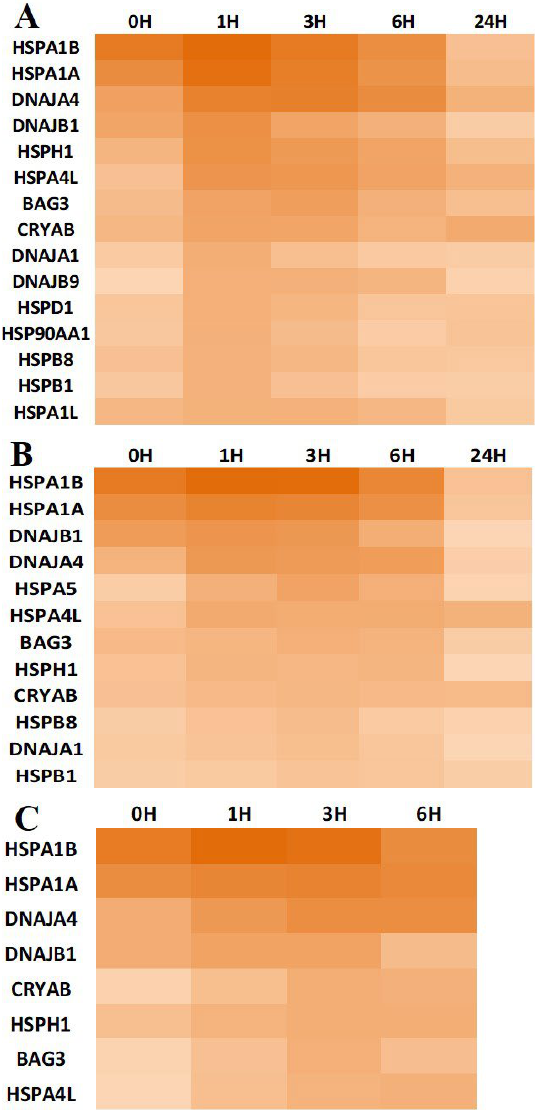
Figure 5. Heat maps showing temporal expression of statistically significantly ( p < 0.05) expressed genes at conclusion of heat stress (0H) and during recovery at 37 °C at 1 h (1H), 3 h (3H), 6 h (6H), and 24 h (24H). Maximal gene-expression time point at 1H in DBMSCs ( A ), 3–6H in DPMSCs ( B ), and 3H in pMSCs ( C ). Additionally, in all the three cell types, significantly high expression of HSPA1A, HSPA1B, DNAJA4, and DNAJB1at 0H is visible. (For Fold Change values and Column Representation, see Table S2 and Figure S2) .